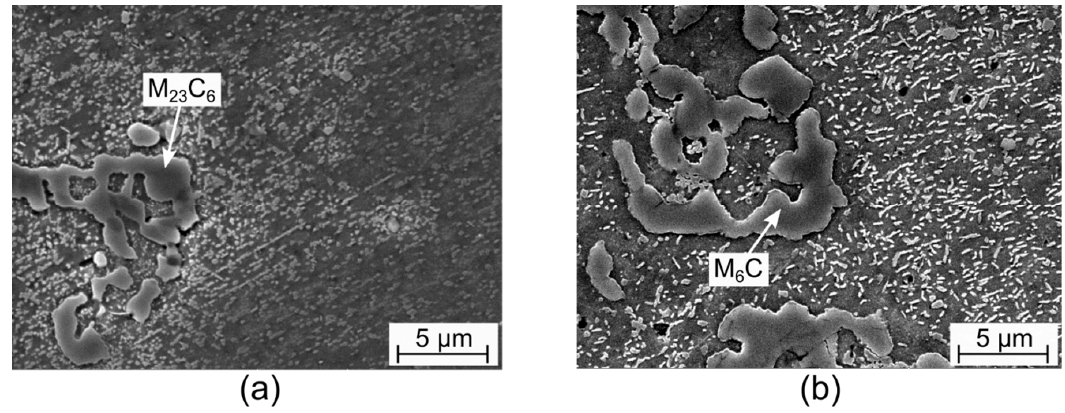
Figure 6. High magnification SEM-micrographs (SE) of the steel 1.4957 ( a ) and 5Mo-2W ( b ) in the aged condition.